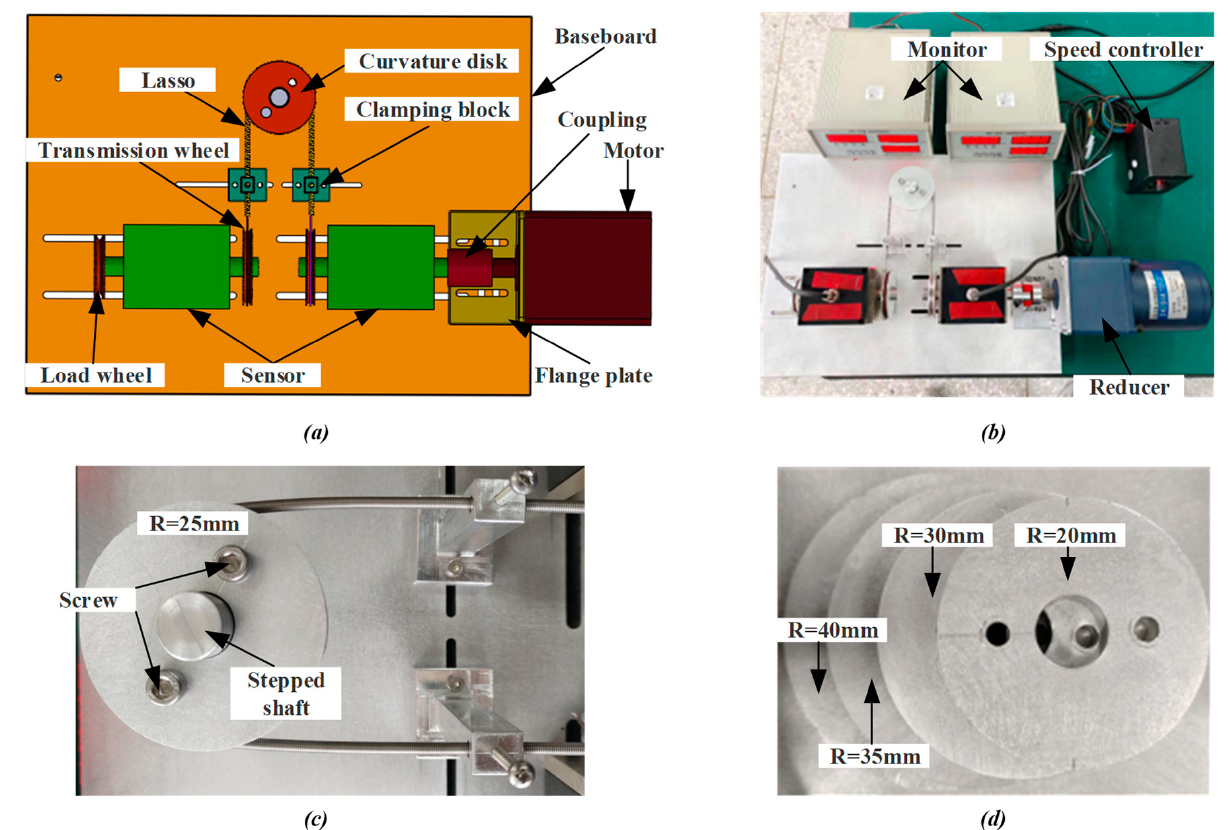
Figure 7. Lasso transmission characteristic analysis test platform. ( a ) Model diagram of test platform; ( b ) Physical diagram of test platform; ( c ) Assembly drawing of lasso mechanism; ( d ) Disc with di ff erent curvatures.